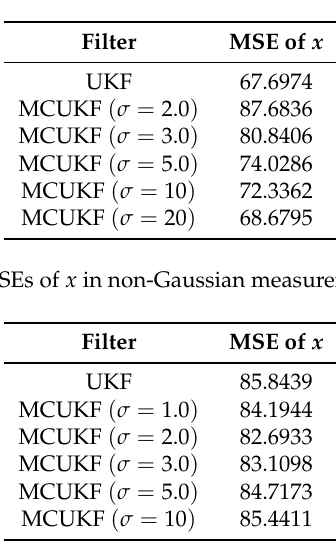
Table 1. MSEs of x in Gaussian noises.